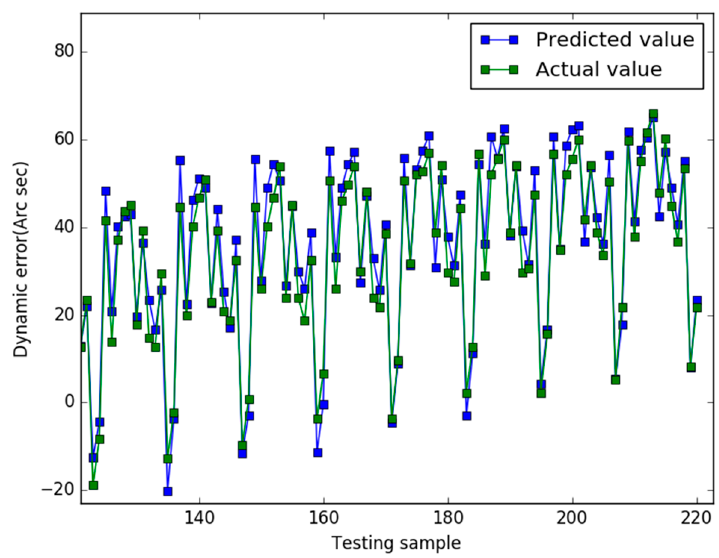
Figure 2. Predicted results of the PSO-SVM (case 1).